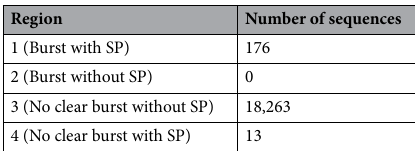
Table 1. Number of sequences in each region shown in Fig.